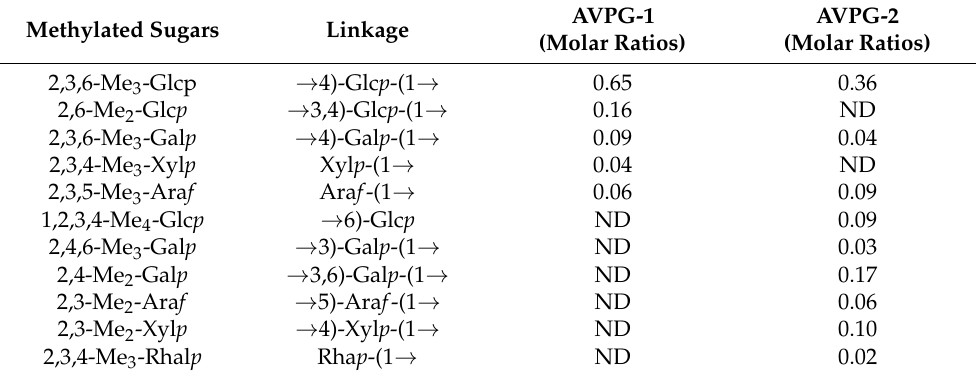
Table 1. Results of the methylation analysis of AVPG-1 and